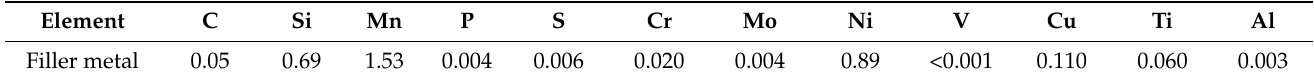
Table 5. Chemical composition of filler metal [1].